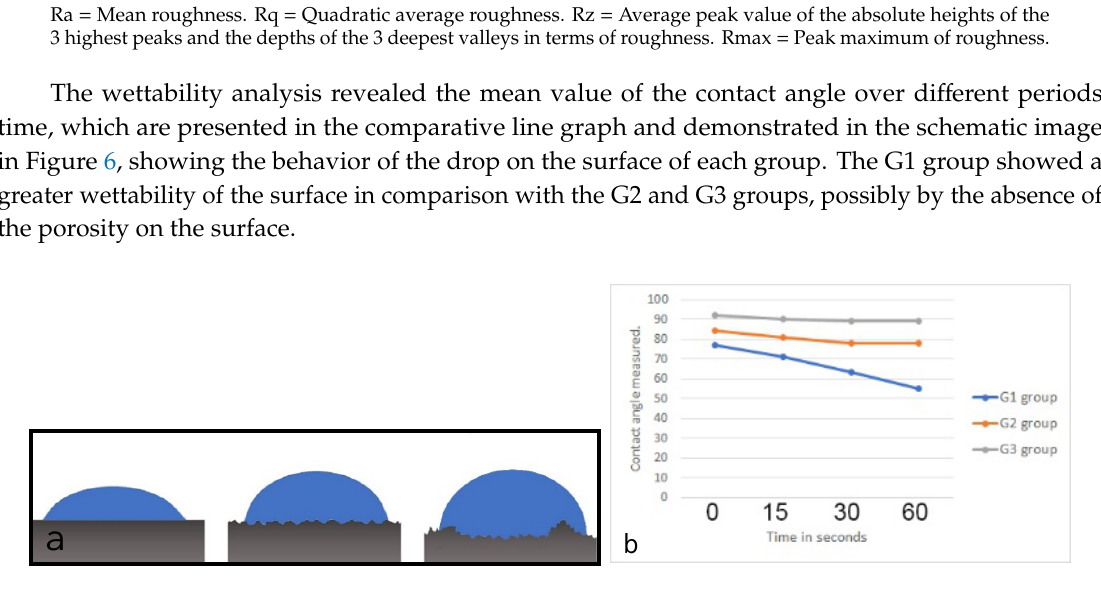
Ra = Mean roughness. Rq = Quadratic average roughness. Rz = Average peak value of the absolute heights of the 3 highest peaks and the depths of the 3 deepest valleys in terms of roughness. Rmax = Peak maximum of roughness.